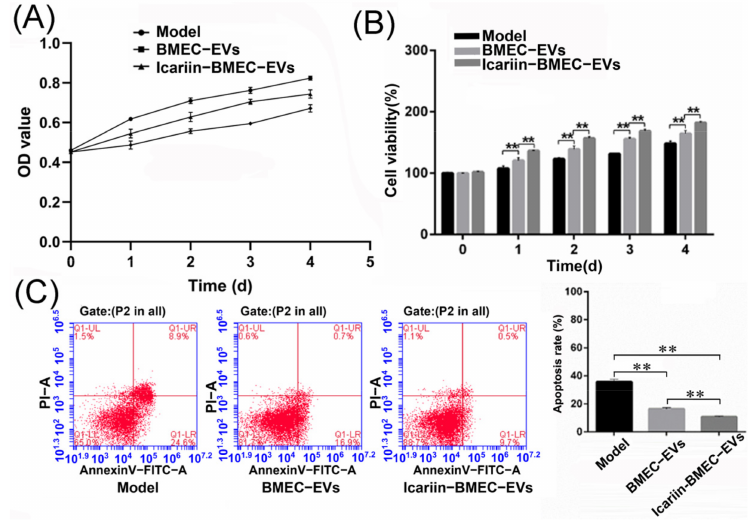
Figure 8. Co-culture with EVs improved the viability and decreased apoptosis of BMECs. These effects are more pronounced in Icariin-BMEC-EVs group than in BMEC-EVs group. ( A ) Detection of OD values at various time points after hydrocortisone intervention; ( B ) cell viability at each time point; ( C ) cell apoptosis detected by flow cytometry. Data were analyzed using one-way analysis of variance and student t -test, error bars indicate standard deviation, and ** indicates p -value <